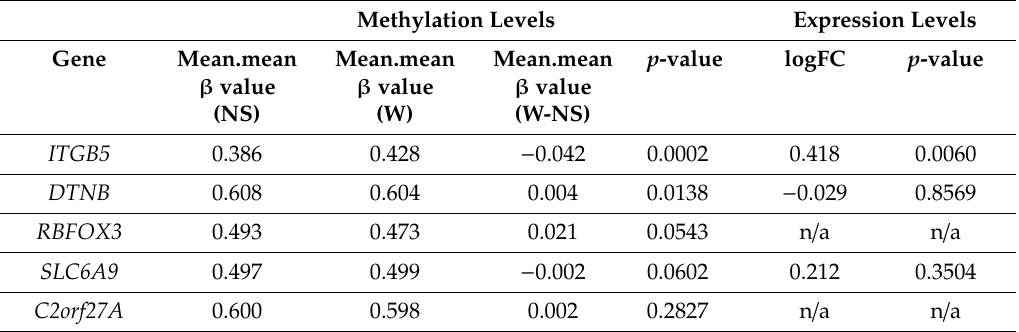
Table 1. Methylation and expression levels of the genes associated with the five top-ranked CpG islands in warts (W) compared to normal skin (NS). Methylation Levels Expression